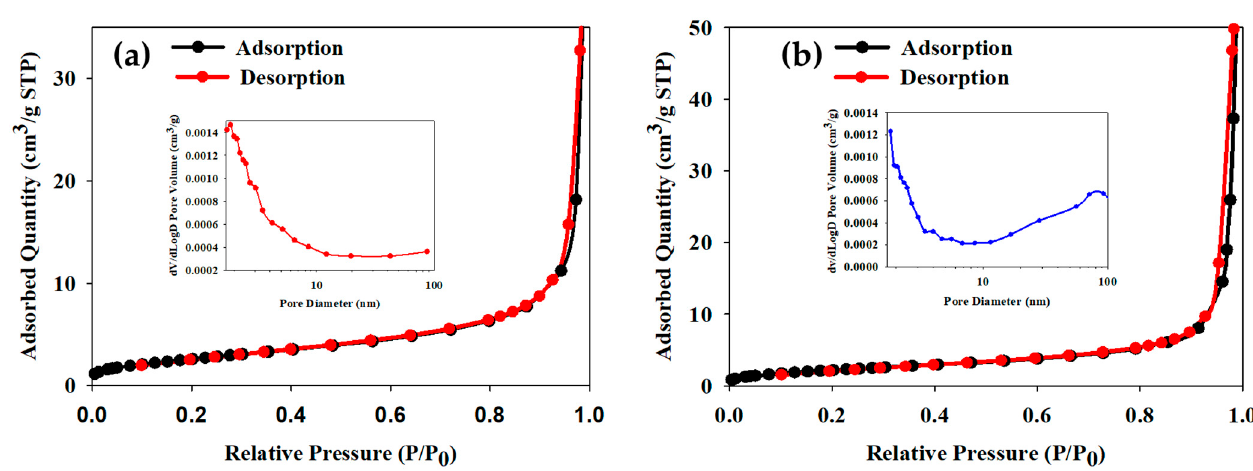
Figure 6. N 2 adsorption-desorption isotherm curve and their respective particle size distribution (PSD) (inset) of ( a ) unmodified HRTiO 2 , and ( b ) modified Mo/HRTiO 2 . (PSD) (inset) of ( a ) unmodified HRTiO 2 , and ( b ) modified Mo/HRTiO 2